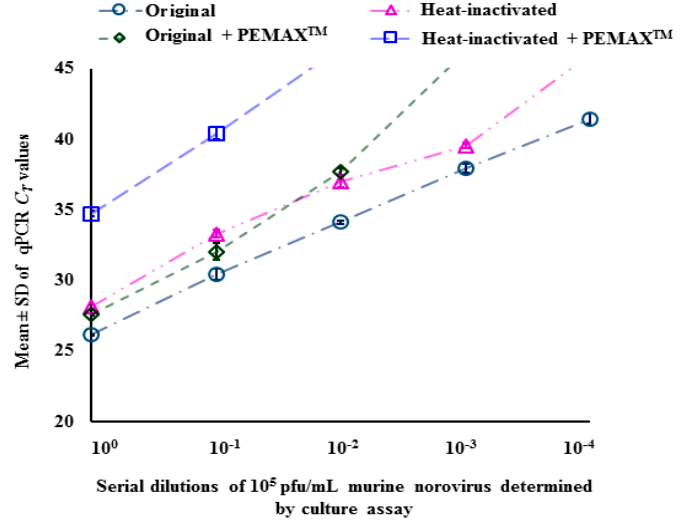
Figure 2. qPCR C T values (mean and standard deviation) of serially-diluted original (non-heat-inactivated) and heat-inactivated murine norovirus with and without PEMAX TM treatment.